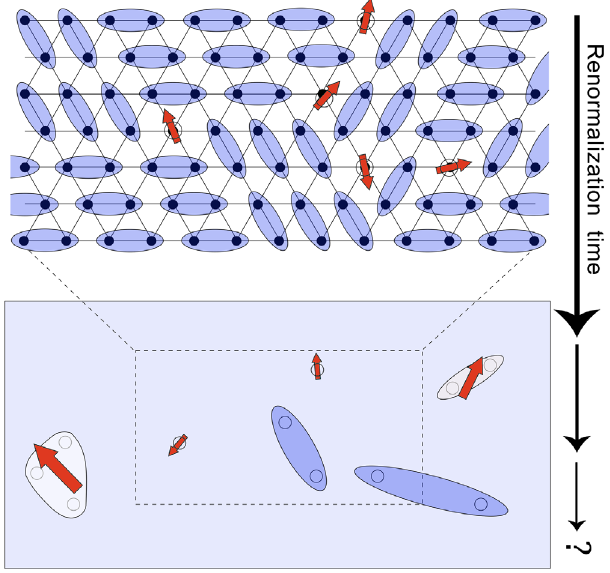
FIG. 1. Spin- 1 = 2 defects in a valence-bond solid (VBS). The valence-bond solid patterns on the triangular lattice shown here (top) admit two types of defects: point defects (vortices) and line defects (domain walls). Each vortex hosts a protected spin 1 = 2 in its core. A particular type of domain wall, here shown separating the sets of domains on the left and the right, also carries dangling spin 1 = 2 . When bond randomness destroys long-range VBS lattice-symmetry-breaking order it also nucleates a random net- work of these defects (bottom): RG flows at low energies can produce longer-range random singlets, larger-spin clusters, and spin-glass freezing of the nucleated